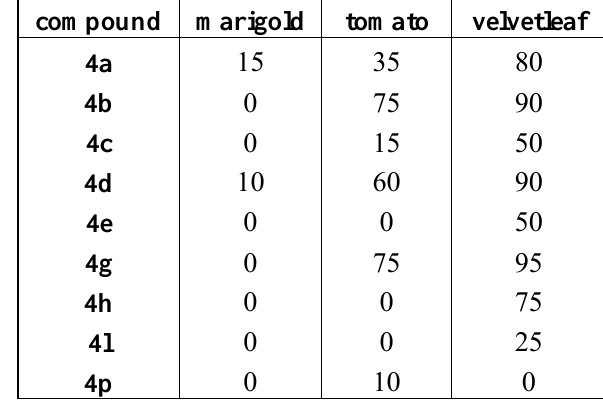
Table 2. Herbicidal activity of 1-phenyl-piperazine-2,6-diones at 1200g/ha (% control) compound marigold tomato